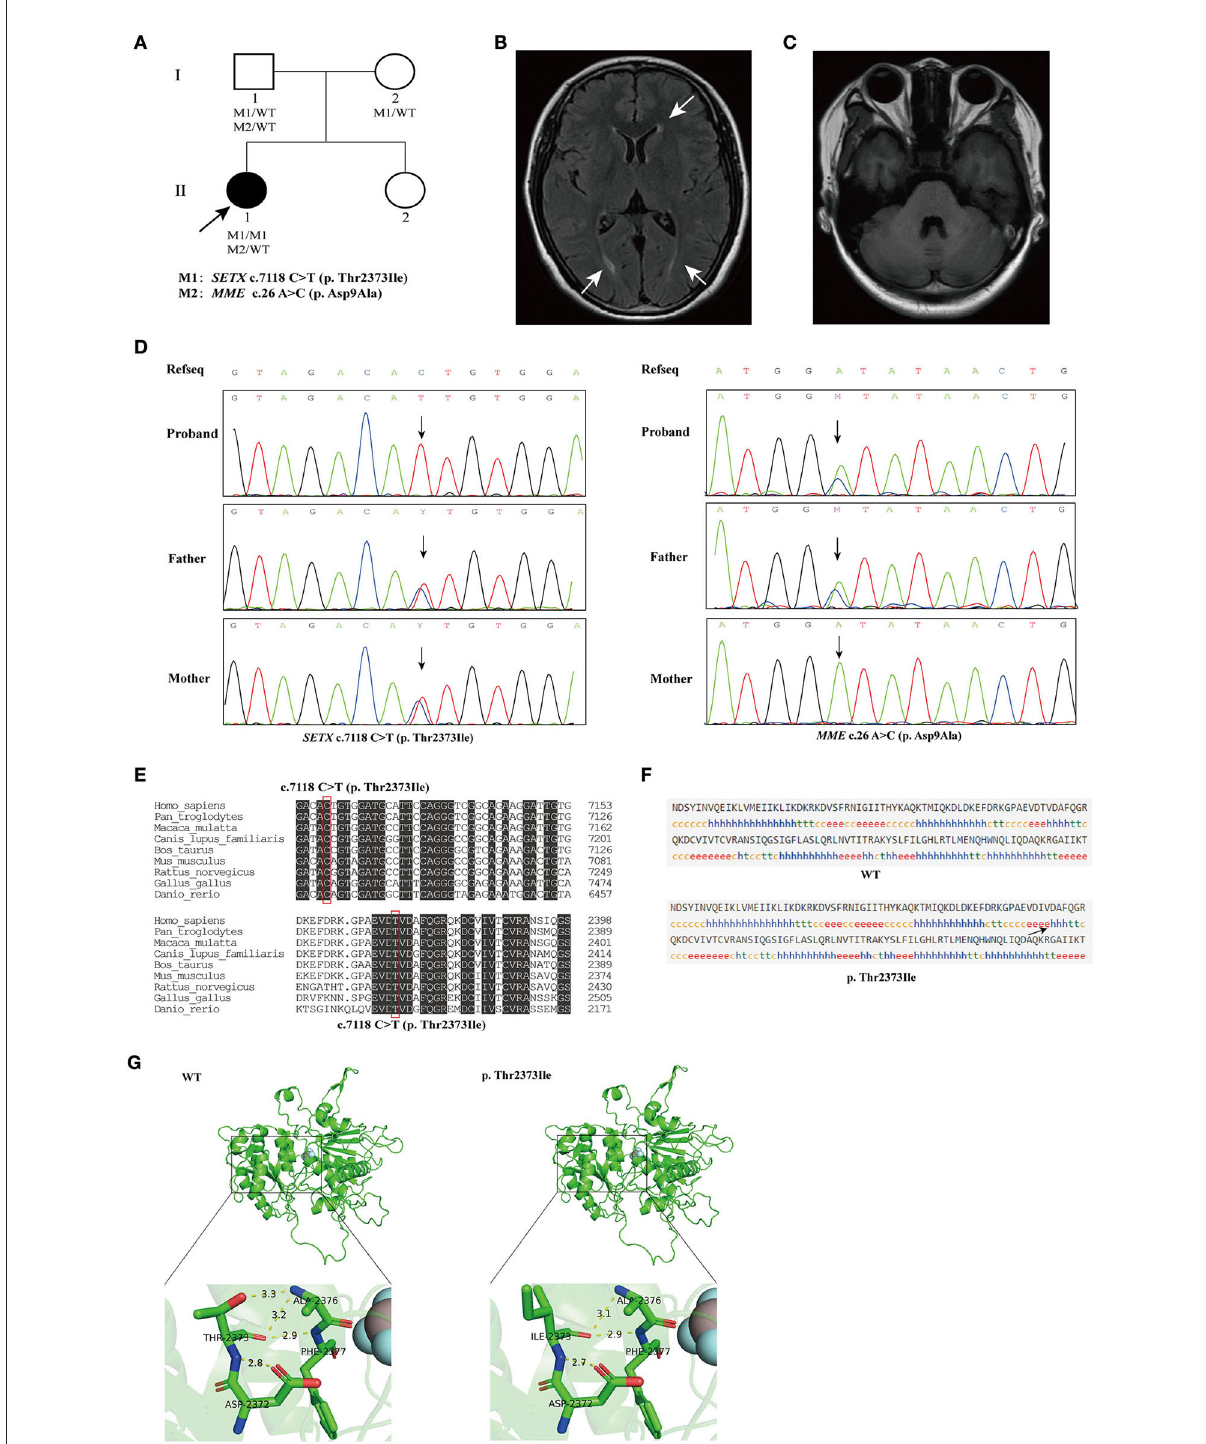
FIGURE1 (A) The pedigree of the family. The black arrow indicates the proband that subjected for Whole-exome sequencing (WES). (B) Brain magnetic resonance imaging (MRI) of the proband, showing mild degeneration of white matter (white arrows). (C) Brain MRI of the proband, showing normal cerebellum. (D) Sequencing results showed that the homozygous variant c.7118C > T (p. Thr2373Ile) of SETX was inherited from both of the proband’s parents (left), and the c.26A > C (p. Asp9Ala) variant in MME was inherited from the proband’s father (right). (E) Conservation analysis of SETX c.7118C > T (p. Thr2373Ile) variant. (F) Secondary structures of wild-type and SETX p. Thr2373Ile variant were analyzed by SOPMA (Self-Optimized Prediction method with Alignment) online. h, α -helix; e, extended strand, arrow indicates change in secondary structure. (G) Prediction of the change in the three-dimensional (3D) structure of senataxin by SETX c.7118C > T (p. Thr2373Ile)